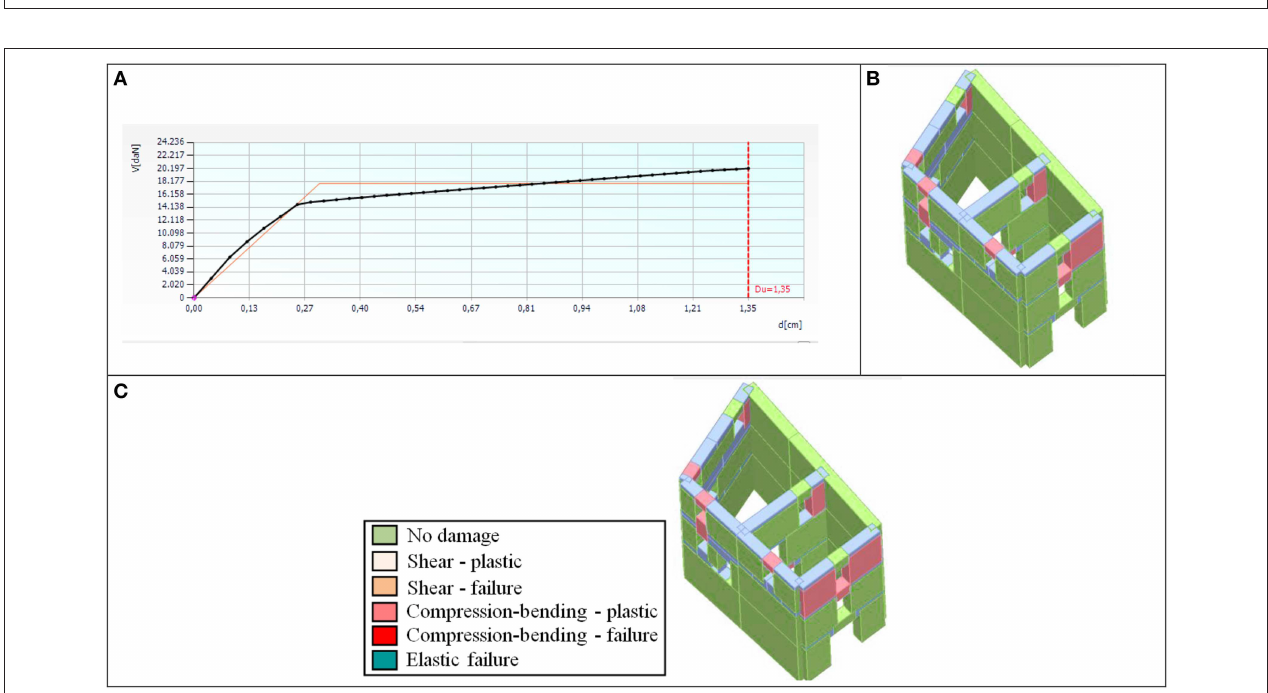
FIGURE 11 | Seismic behavior in direction Y of the isolated S.U. type C: MDOF pushover curve (A) and damage patterns related to the conventional yielding limit (B) and ultimate displacement D u (C) .